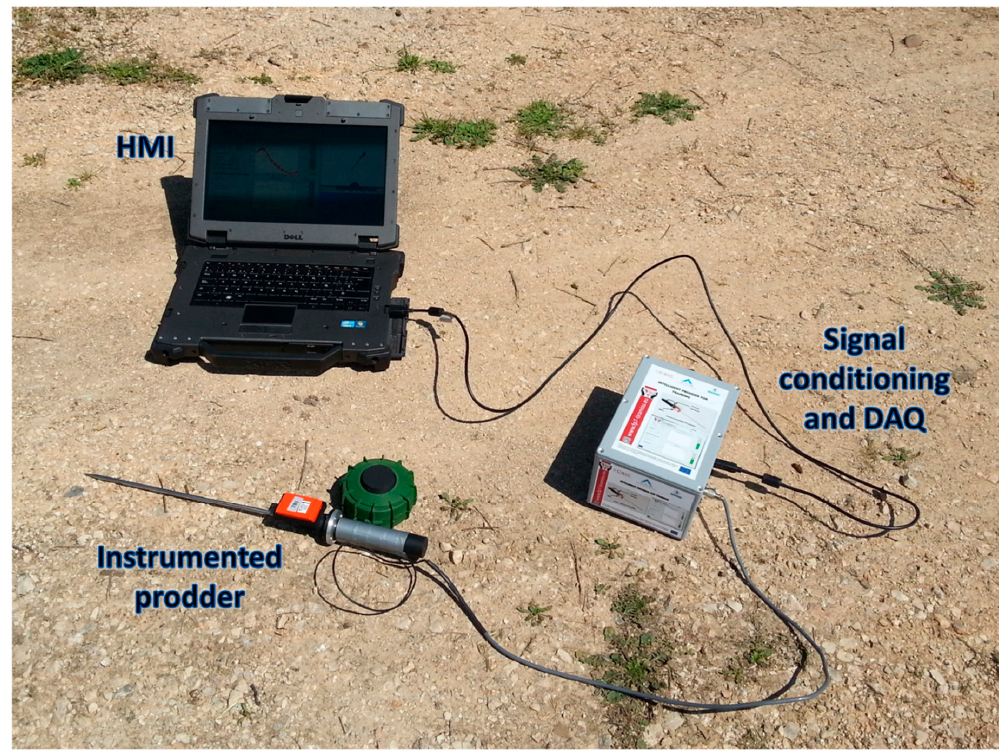
Figure 7. Prototype of the propose tool used during the experimental stage.